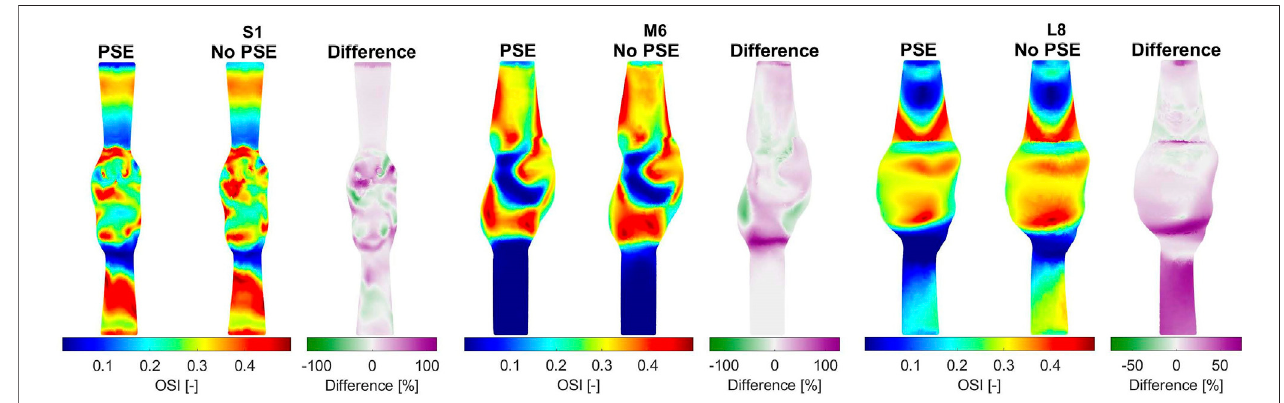
FIGURE 11 | Visualization of (A) the 1st percentile TAWSS and (B) the 99th percentile OSI for both FSI simulations for the different patient groups. (C,D) Visualize the difference in 1st/99th percentile (black) and average absolute spatial difference (blue) between the FSI simulations for the TAWSS and OSI, respectively. Signi fi cant differences between groups are indicated with bars and stars (** p ≤ 1e-2, * p ≤ 0.05).